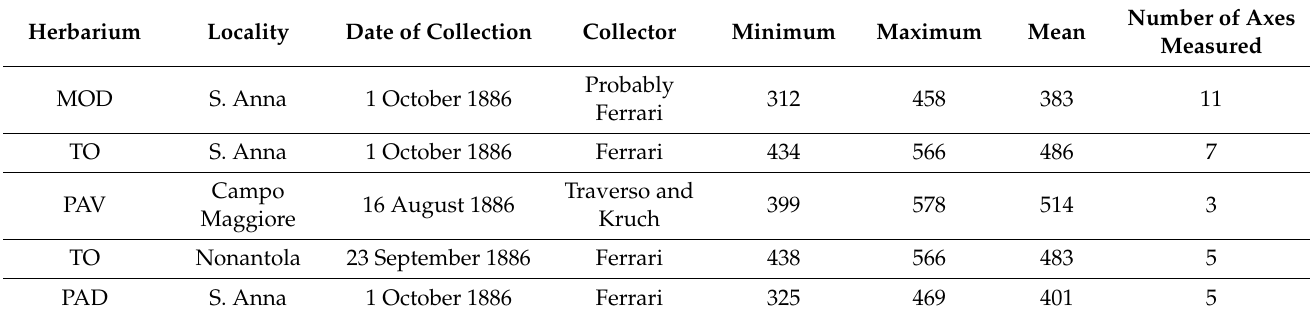
Table 3. Diameters of axes. All values are presented in µ m.